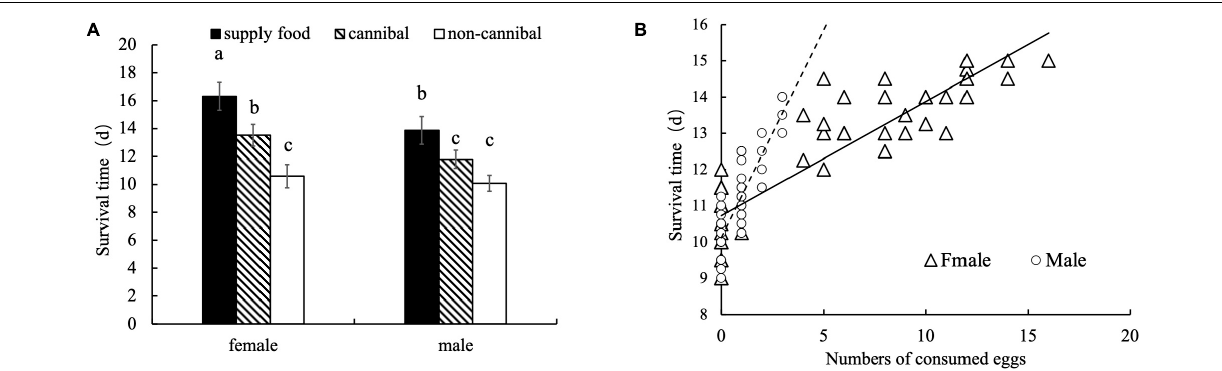
FIGURE 8 | Egg cannibalistic behavior exhibited by A. custos adults incubated at different egg or predator densities. Different uppercase letters indicate significant differences among females ( p < 0.05), and different lowercase letters indicate significant differences among males ( p < 0.05). (C,D) The number of consumed eggs overall individual. A total of 30 replicates were used for each experiment. Numbers of A. custos adults exhibiting cannibalistic behavior in no-choice (A) and free-choice (B) condition. Numbers of A. custos adults consumed eggs in no-choice (C) and free-choice (D) condition. Ratio of remained eggs in no-choice (E) and free-choice (F) condition..